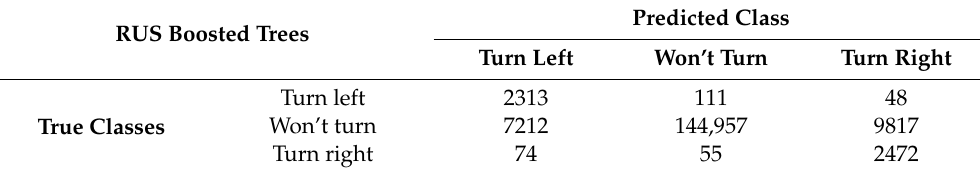
Table 9. The confusion matrix of the RUS boosted trees with 0.1 s prediction time.